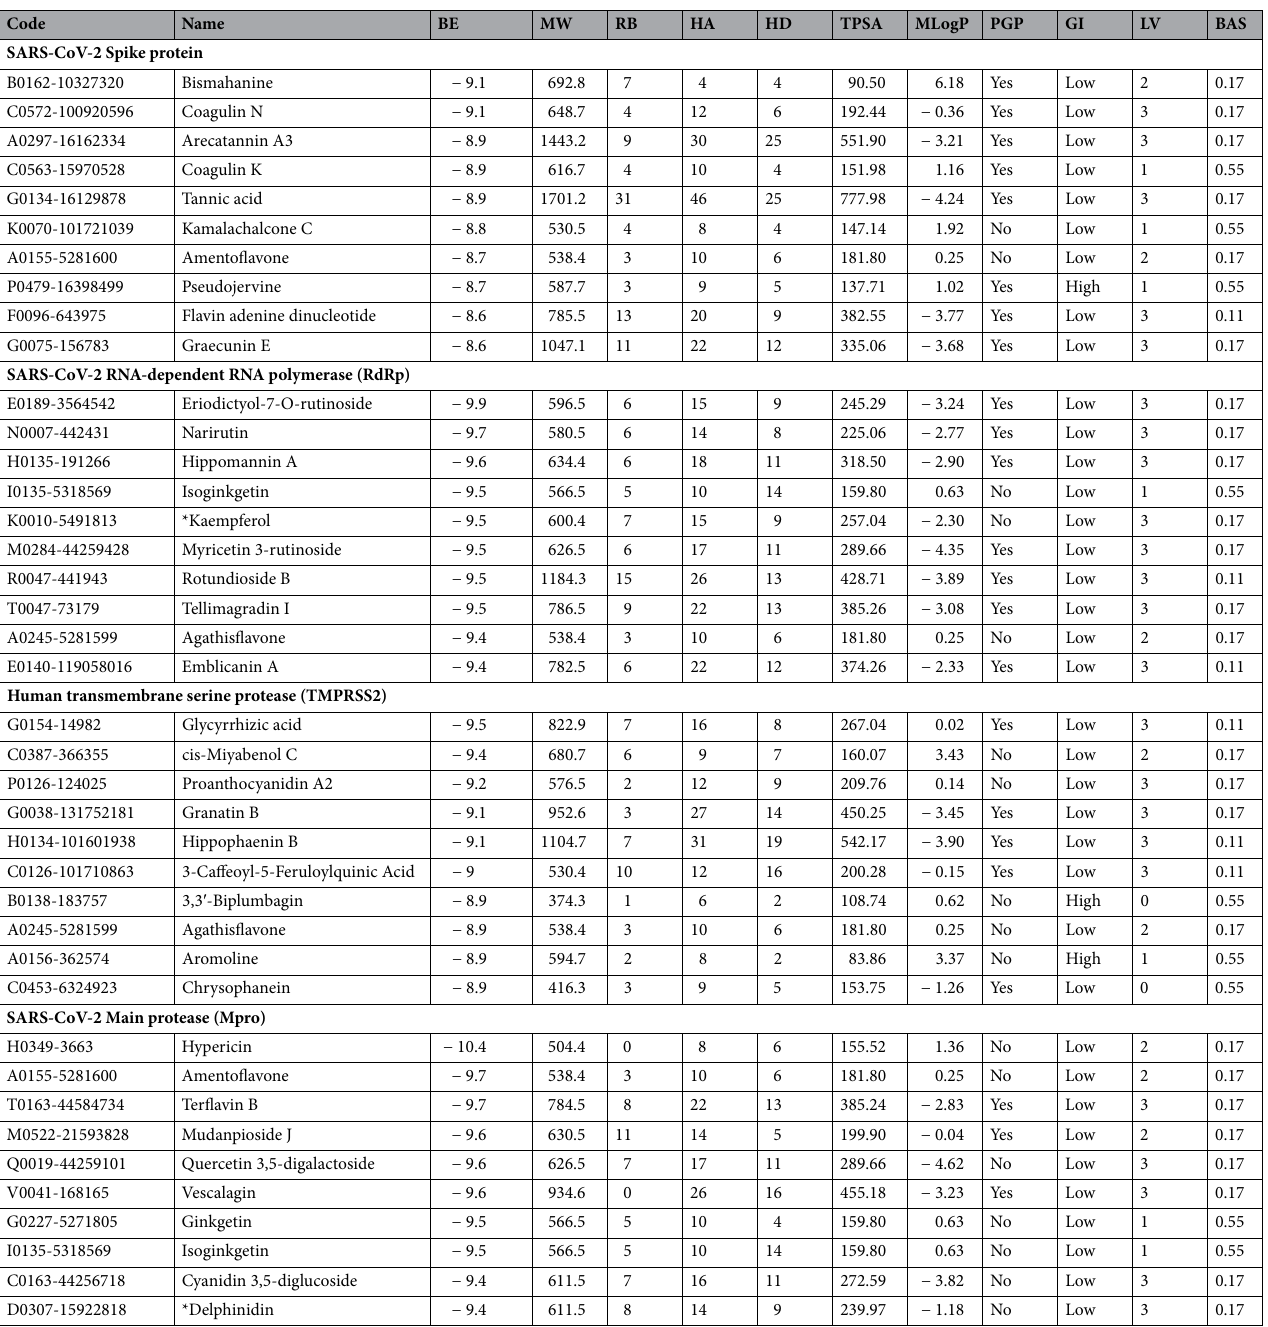
Table 1. Binding energy of top ranked plant secondary metabolites against four targets of SARS-CoV-2 pathogenesis and their physicochemical properties. Only top 10 ranked molecules against each target are represented here. Details of all the plants secondary metabolites studied are available in Supplementary Files 2 and 3. BE, binding energy (Kcal/mol); MW, molecular weight (g/mol); RB, number of rotatable bonds; HA, number of H-bond acceptors; HD, Number of H-bond donors; TPSA, total polar surface area (Å 2 ); MLogP, predicted octanol/water partition coefficient; PGP-S, pgp substrate; GI, GI tract crossing, LV, Number of Lipinski’s rule violation; BAS: bioavailability score. *Kaempferol 3-O-(6 ′